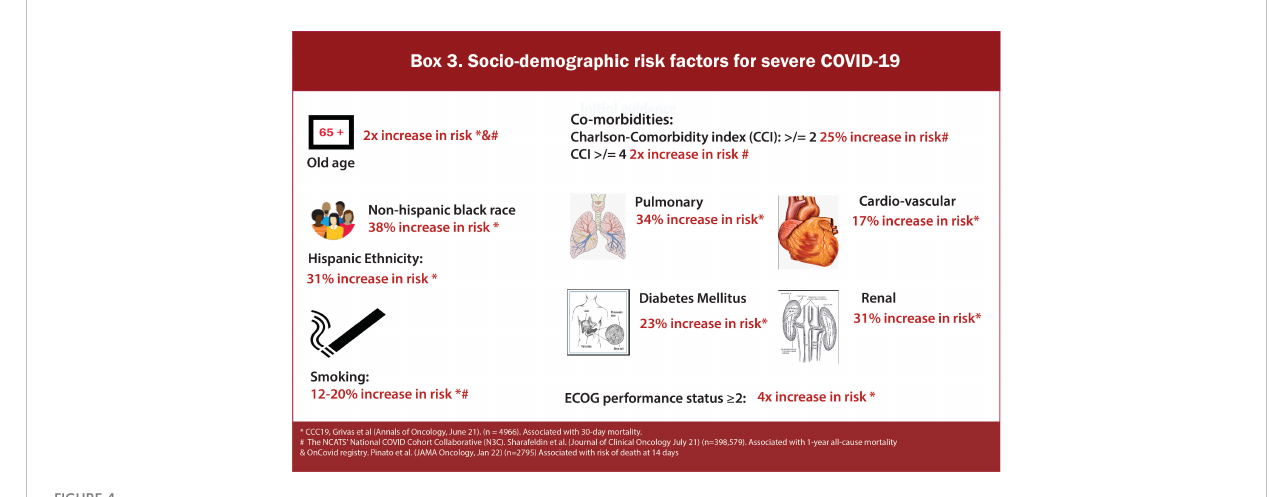
FIGURE 4 Box-3 Socio-demographic risk factors for severe